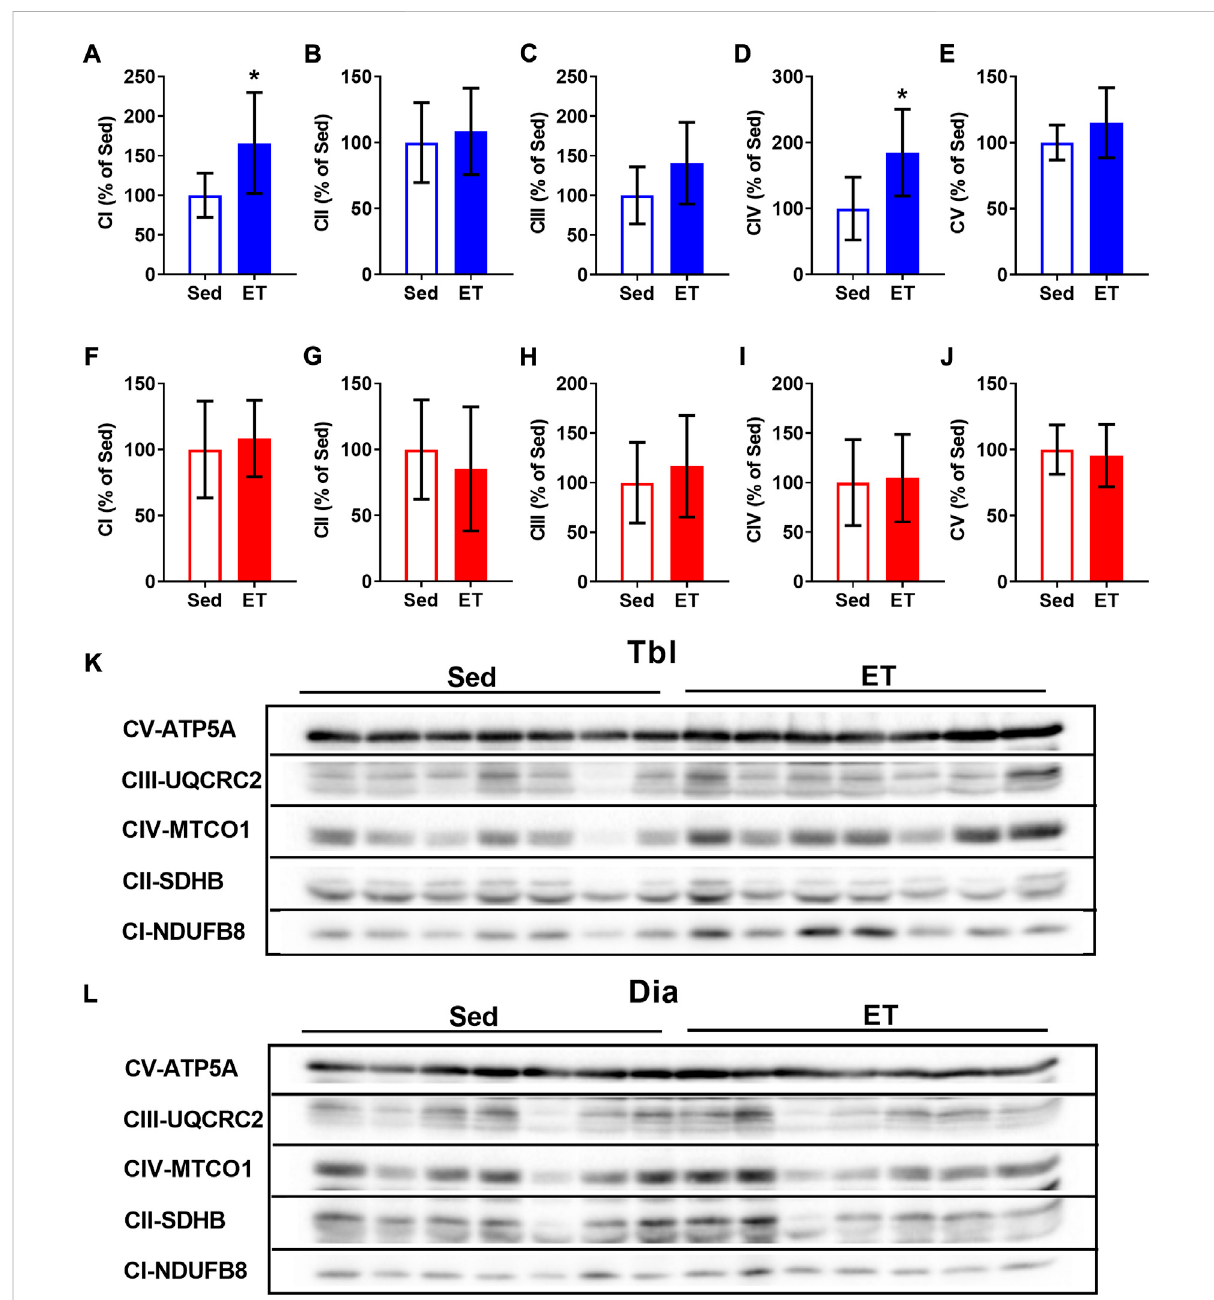
FIGURE 4 Voluntary exercise training increased the contents of oxidative phosphorylation complexes in long head of the triceps brachii muscle (Tbl) but notindiaphragmmuscle(Dia).TherelativecontentsofCI (A,F) ,CII (B,G) ,CIII (C,H) ,CIV (D,I) andCV (E,J) oxidativephosphorylationcomplexesinTbl (A – E) and Dia (F – J) of sedentary rats (Sed, n = 7) and voluntary exercise-trained (ET, n = 7) rats. Representative Western Blot images of oxidative phosphorylation complexes in Tbl (K) and Dia (L) in sedentary and voluntary exercise-trained rats. Images of CI-CV complexes were taken